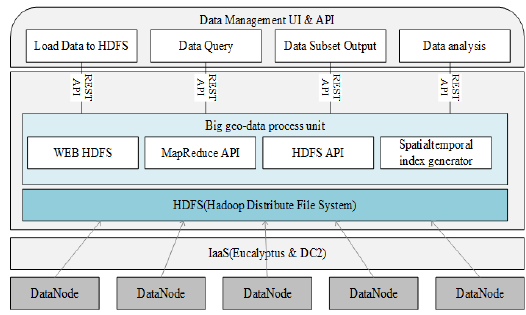
Figure 2. HDFS-based big data management architecture